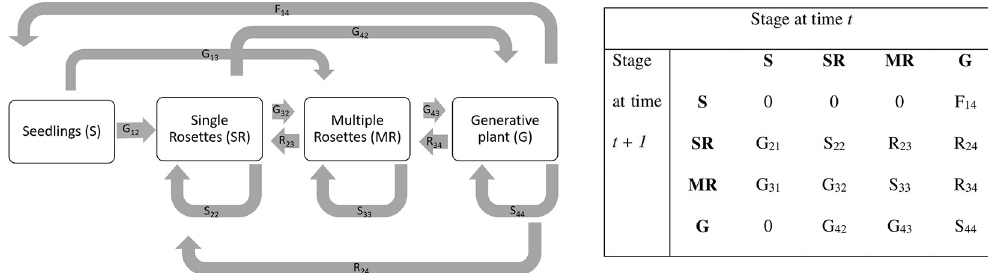
Fig 2. Life cycle graph for J . vulgaris and the corresponding transition matrix. Boxes indicate life stages, arrows represent the possible transitions between them, and letters show the connection between each transition and its matrix entry (F, fecundity; G, growth; S, stasis; R,